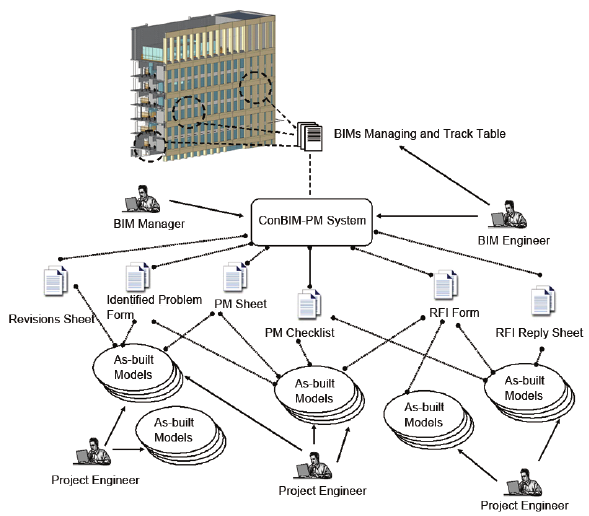
Fig. 2. Concept of BIM PM work for GC during the construction phase